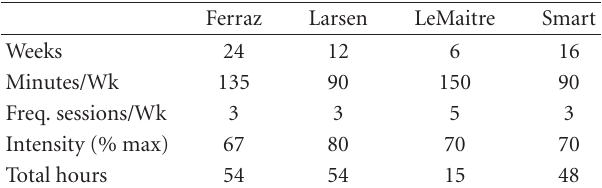
Table 2: Clinical characteristics and pharmacotherapy of the 106 patients.